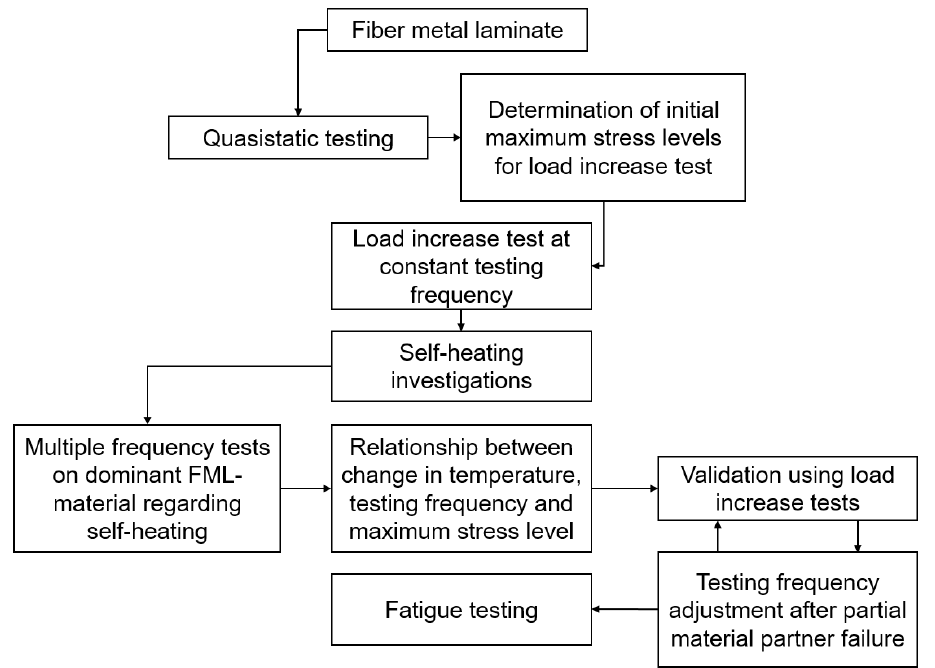
Figure 3. Flow chart showing the developed testing procedure for a reproducible characterization of the mechanical properties of fiber metal laminate under fatigue load.